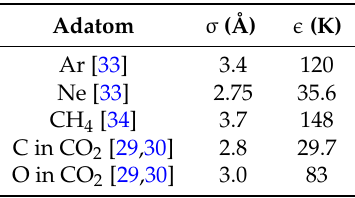
Table 1. Lennard–Jones (LJ) parameters used in the